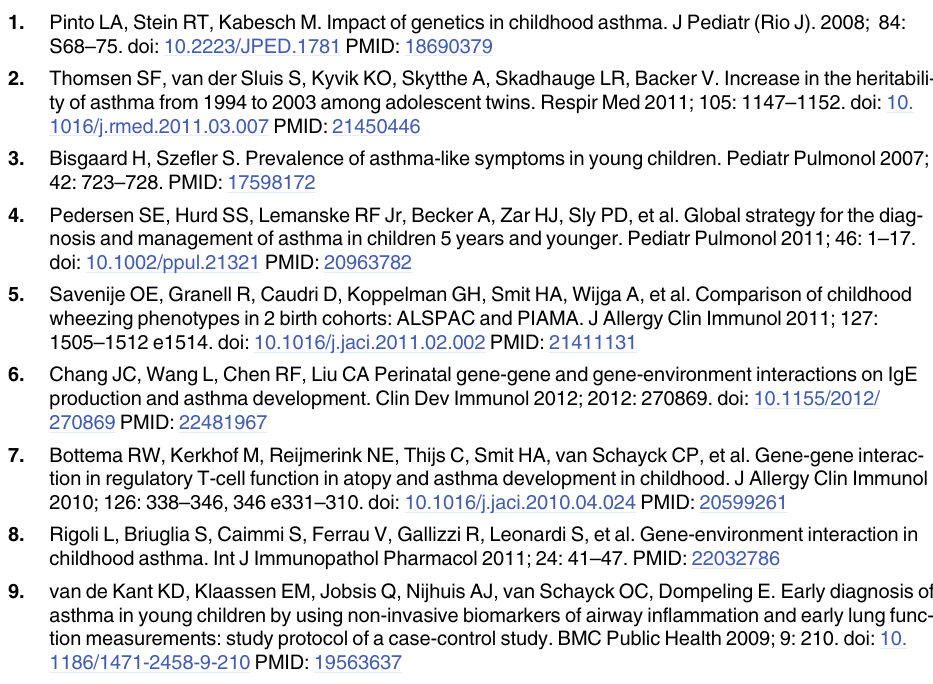
S3 Table. Results of additional model analysis of significant genetic variants in the ADEM study. a Adjusted for sex and exposure to parental smoking and furry pets. Abbreviations: 95% CI: 95% Confidence Interval; A: Asthma; n: number of children; OR: Odds Ratio; p: p-value;